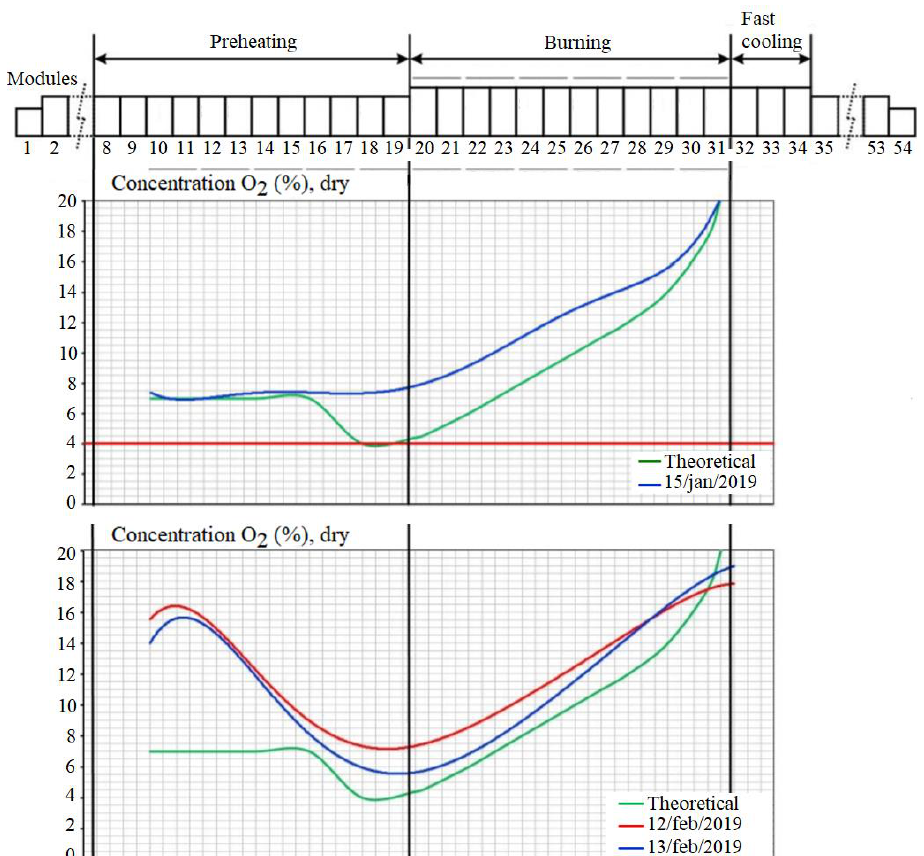
Figure 5. O 2 concentration along the length of a ceramic tile furnace.